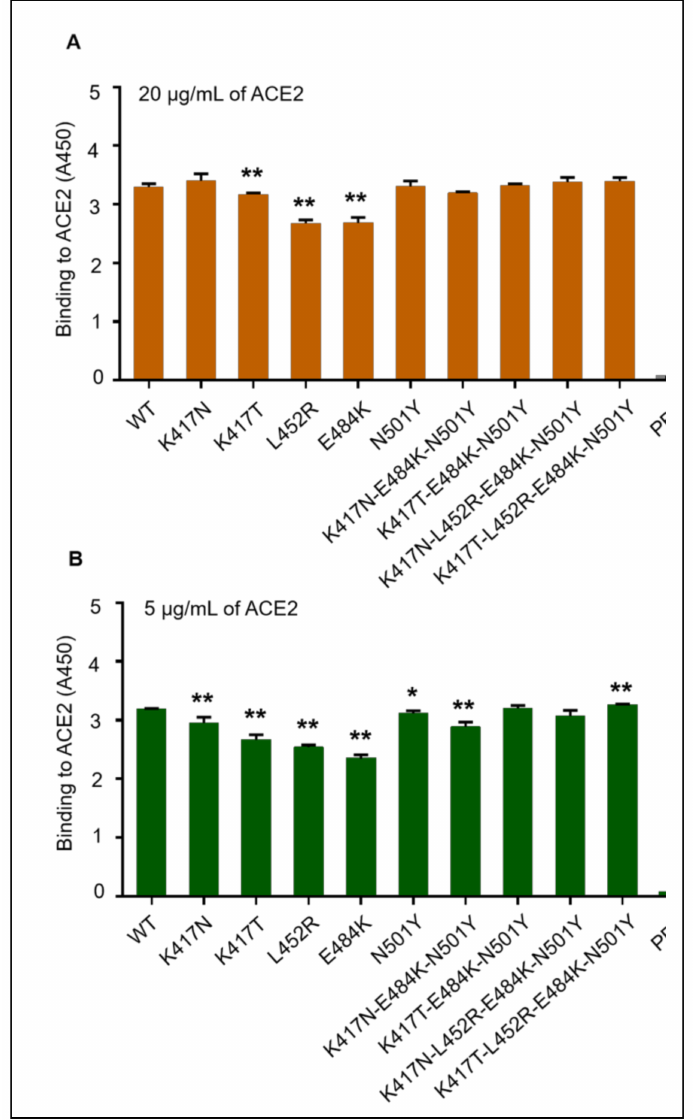
Figure 2. Binding affinity of mutant SARS-CoV-2 RBD-Fc proteins with hACE2. Wild-type RBD-Fc protein and each mutant RBD-Fc protein were coated in 96-well plate respectively, and then reacted with recombinant hACE2 protein in ELISA. ( A ) Binding of each RBD-Fc protein with 20 µ g/mL of hACE2 protein; ( B ) binding of each RBD-Fc Protein with 5 µ g/mL of hACE2 protein. The data of A450 in each group were presented as mean ± standard deviation (SD) of four replicate wells. * ( p < 0.05) and ** ( p < 0.01) mean significant differences between the mutant RBD-Fc protein